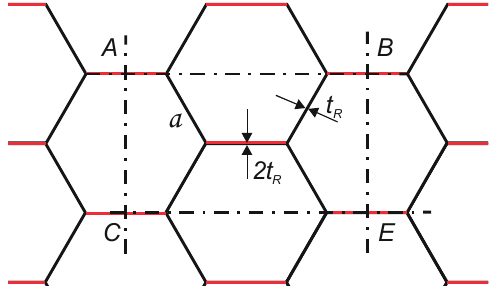
Figure 4. ABCE periodic cell extracted from the paperboard core.